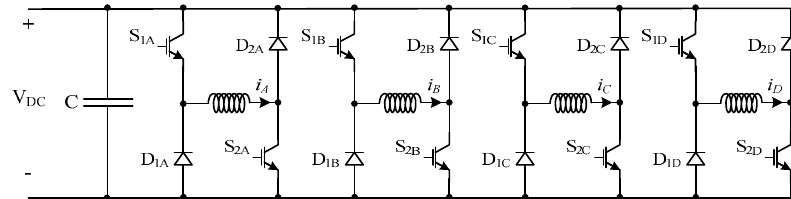
/ 6 switched reluctance